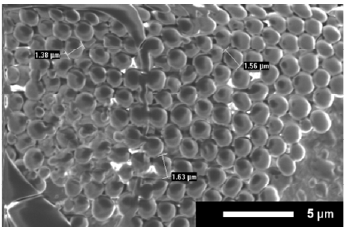
Figure 6. SEM image of uniform surface coating on a glass slide. Coating is B in